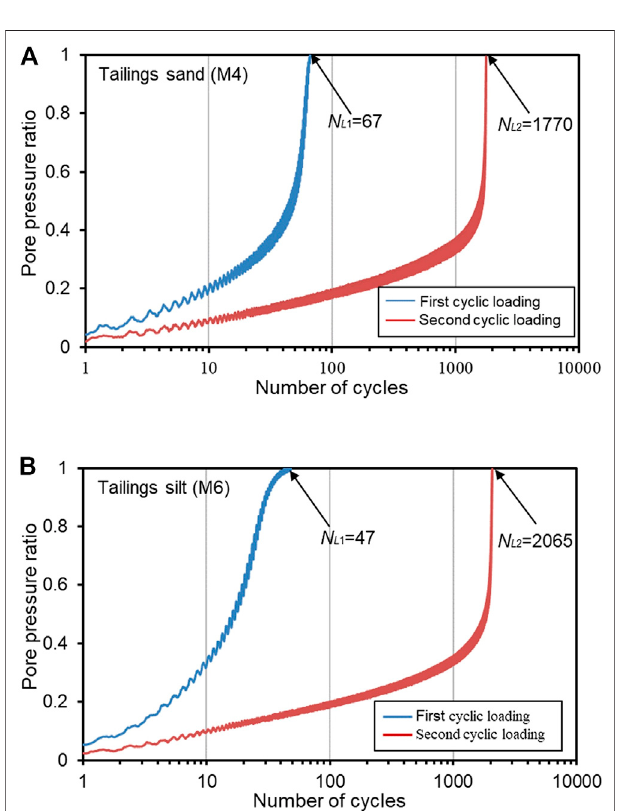
FIGURE 6 | Relationship between the excess pore water pressure ratio and the number of cycles during the two cyclic loading of tailings under full consolidation: (A) tailing sand (M4) and (B) tailing silt (M6).